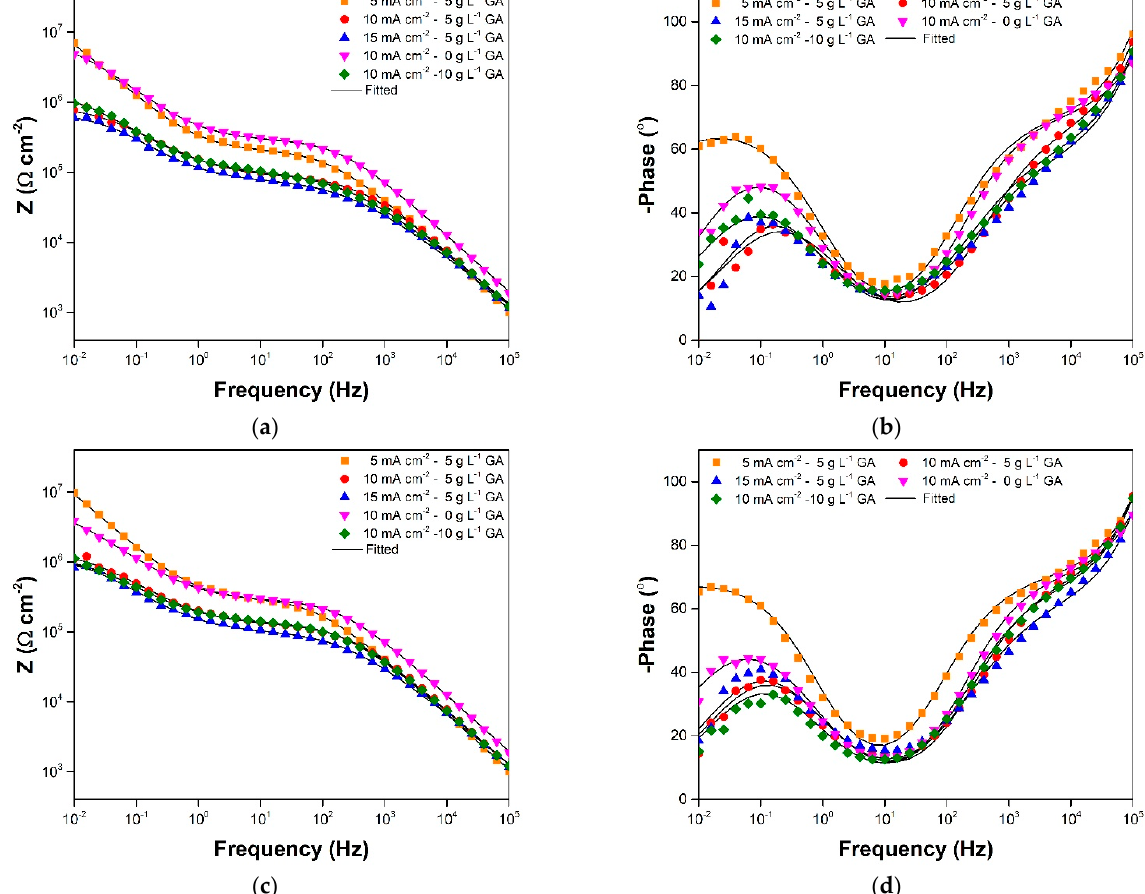
Figure 5. Bode-modulus and Bode-phase plots at ( a , b ) 15-day; and ( c , d ) 20-day immersion in 3.5 wt.% NaCl maintained in ambient conditions. Coatings 2021 , 11 , x FOR PEER REVIEW